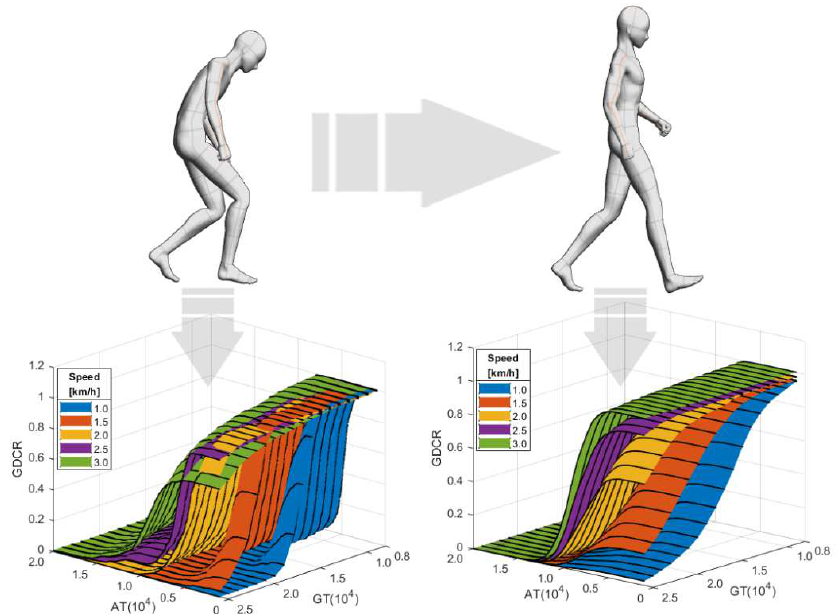
Figure 9. Application of the GDC method. The GDC method could be used for gait disorder evaluation and diagnosis.